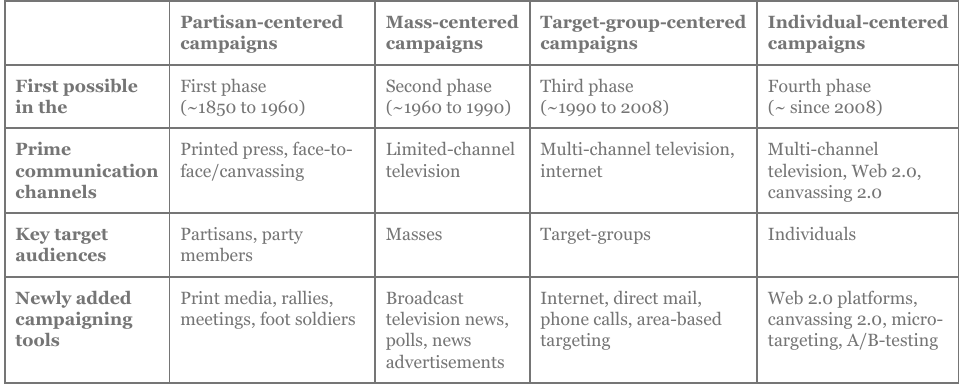
Table 1: Model of ideal campaign types (adapted from Magin et al., 2017). Partisan-centered campaigns